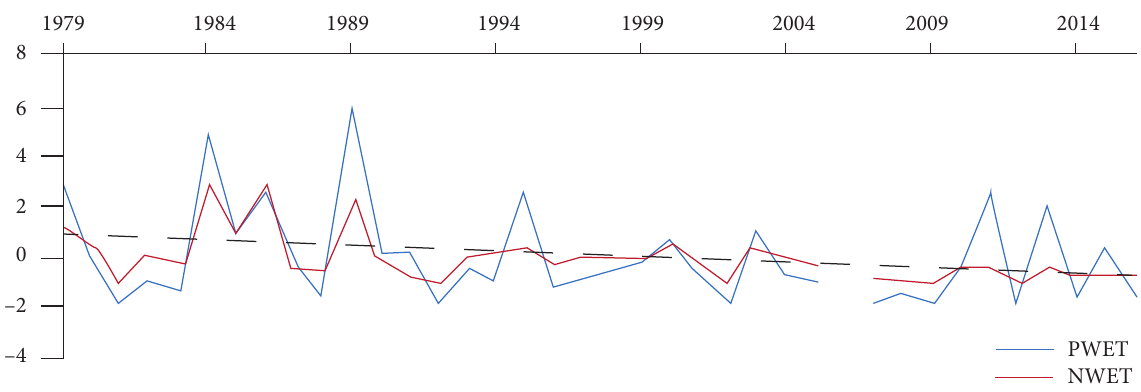
Figure 3. Time series of normalized values of PWET (blue) and NWET (red). In the vertical axis, one unit is equivalent to the standard deviation. The regression lines for PWET and NWET are nearly identical and are indicated by the dashed black line. Period: 1979-2016, except 2006 (37 years).